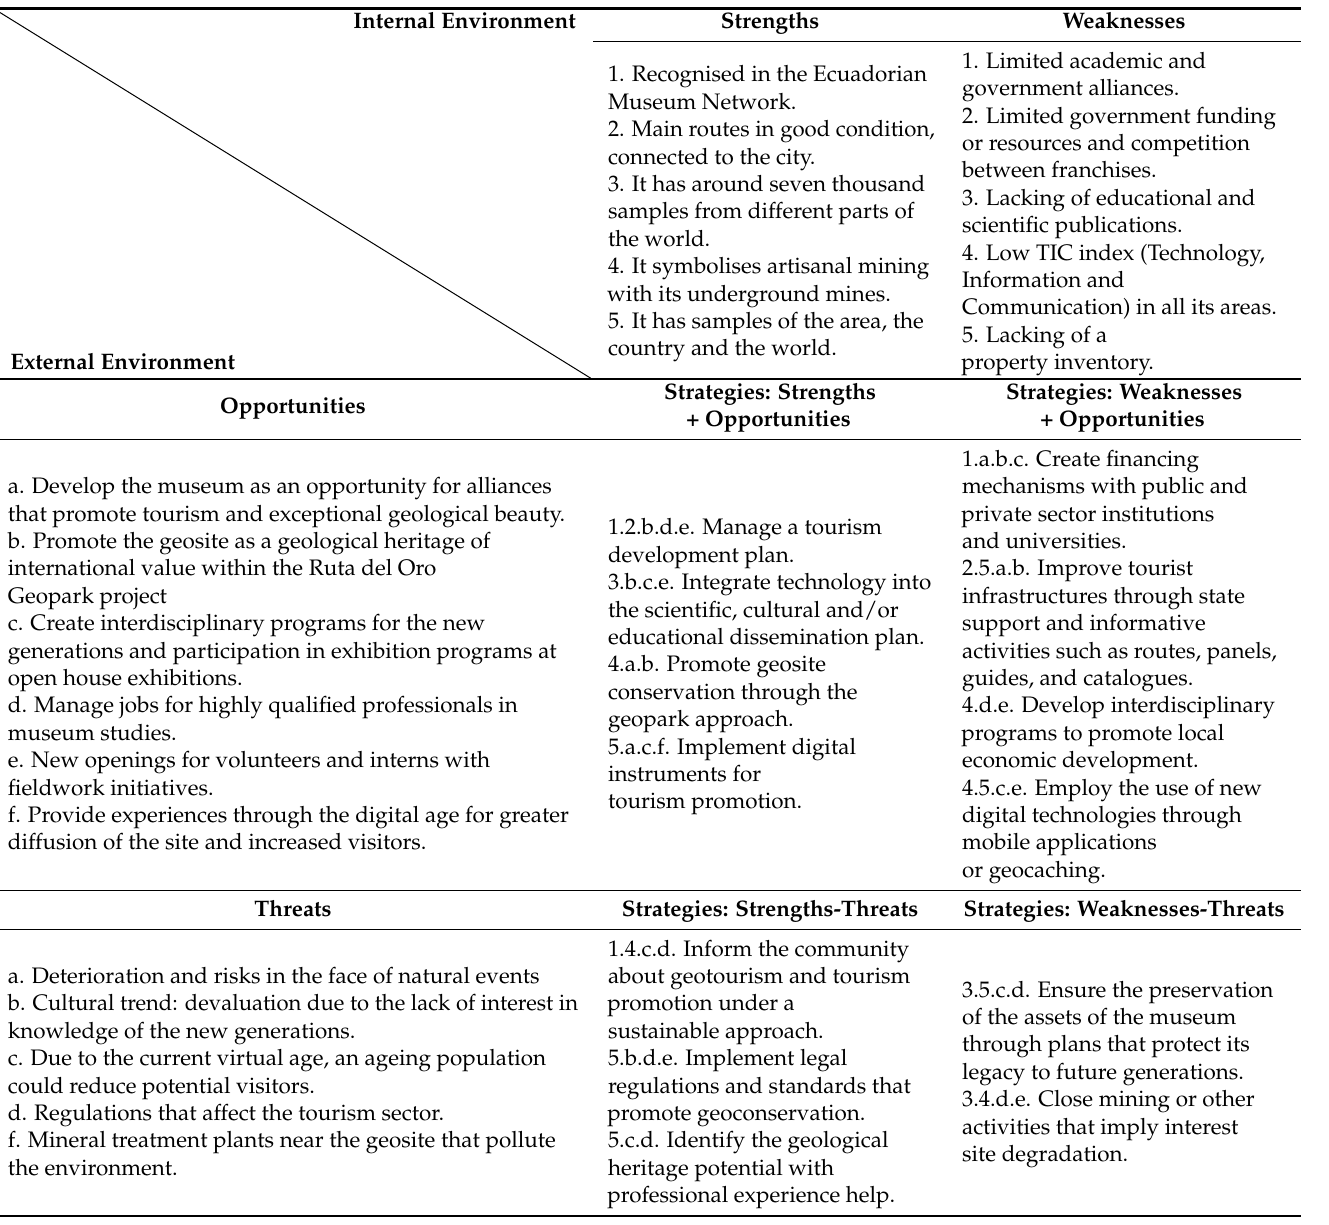
Table 6. Strengths, weaknesses, opportunities and threats (SWOT) matrix of the